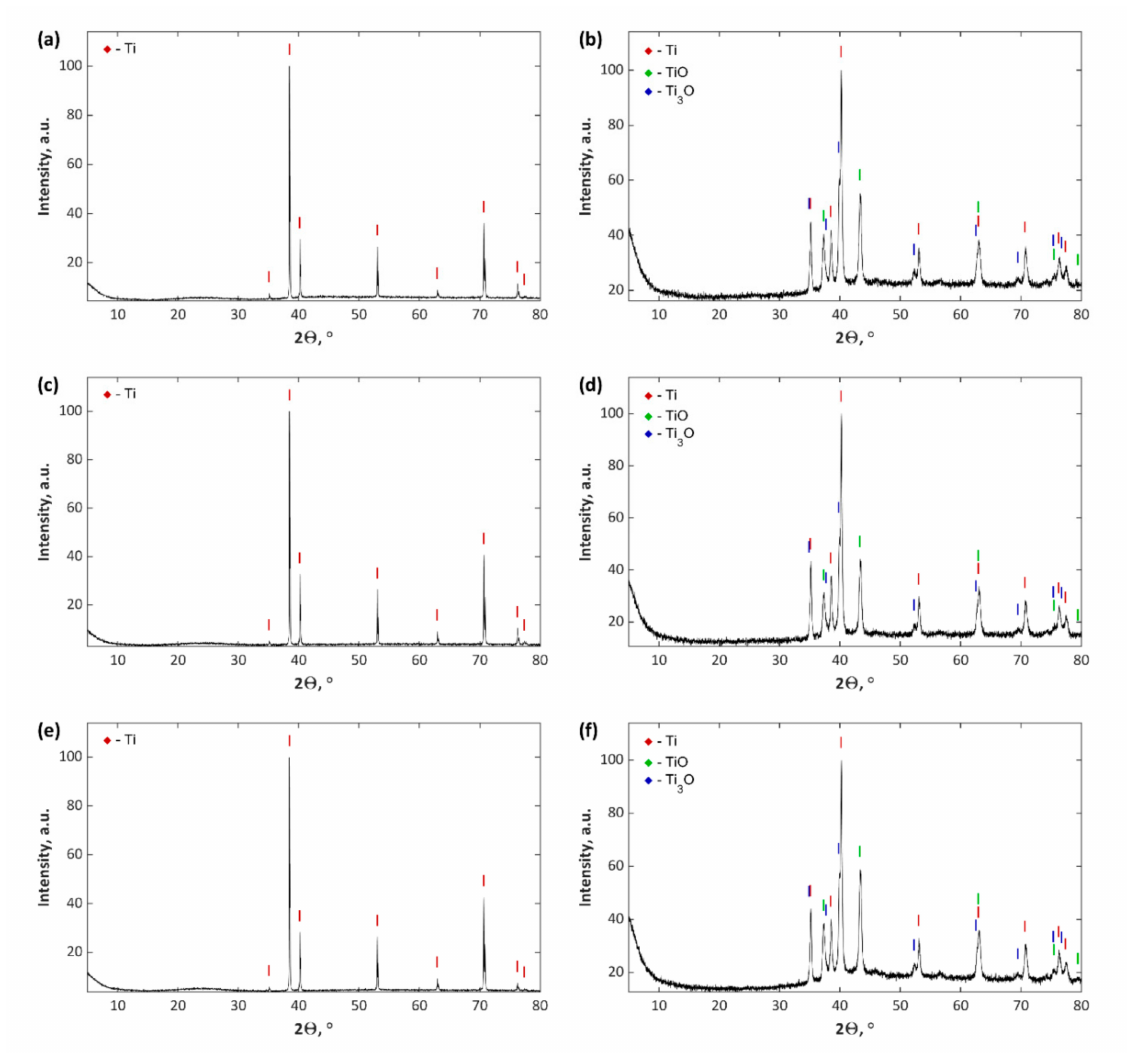
Figure 8. XRD di ff ractograms of PEO coatings: ( a ) TiZnCu-35; ( b ) TiZnCu-135; ( c ) TiZnCuCa-35;